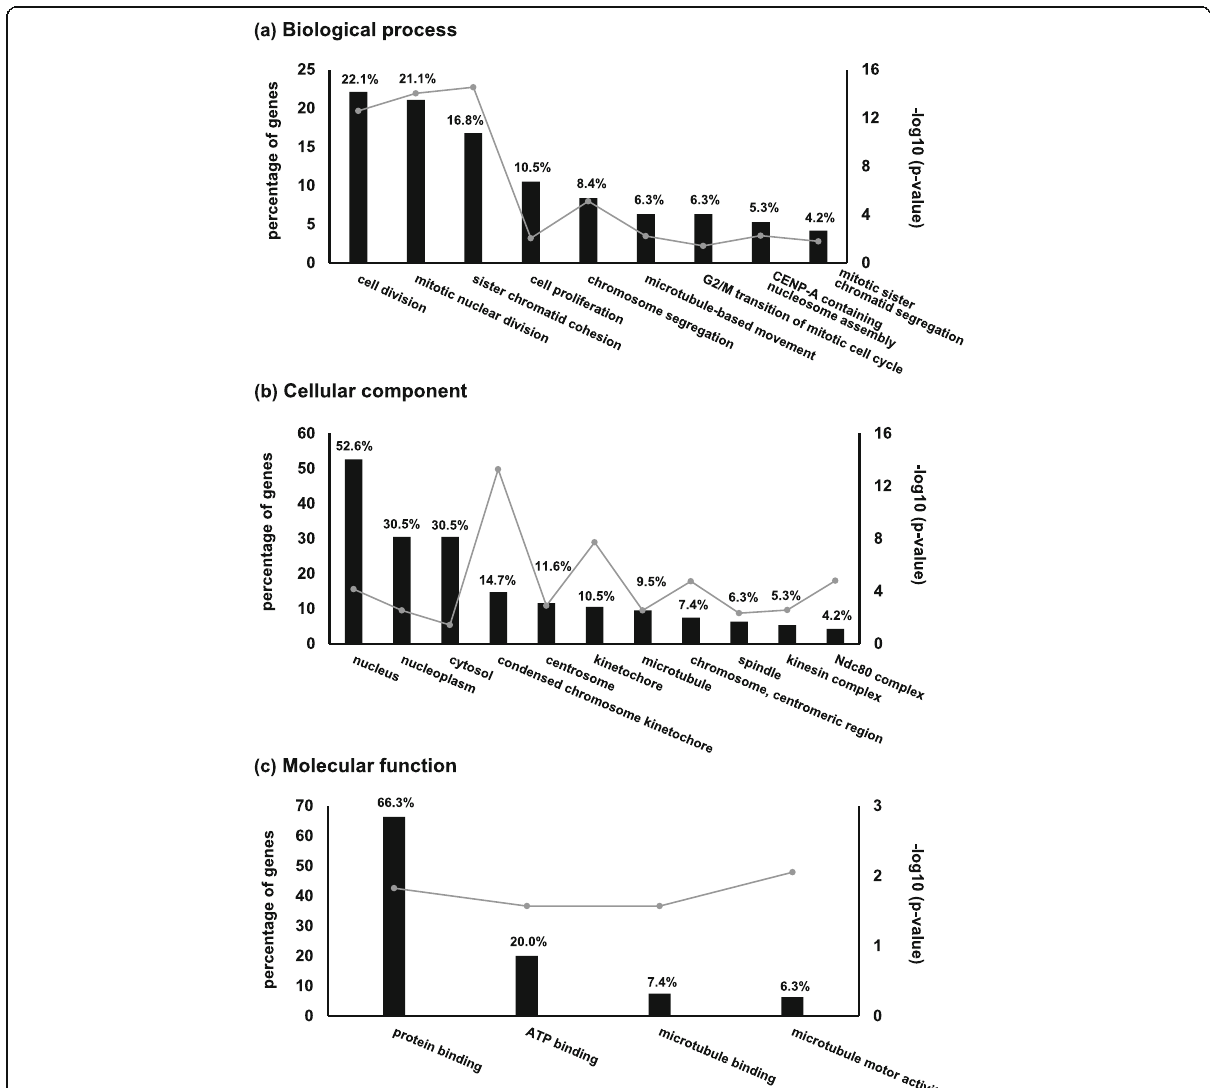
Fig. 2 Gene Ontology enrichment analysis of the upregulate genes shown in Table S2. Bar graphs represent the percentages of genes involved in each term of biological process (BP) ( a ), cellular component (CC) ( b ), and molecular function (MF) ( c ). Line graphs represent the Benjamini corrected p values (significant difference, p < 0.05). Significantly enriched GO terms were shown in these